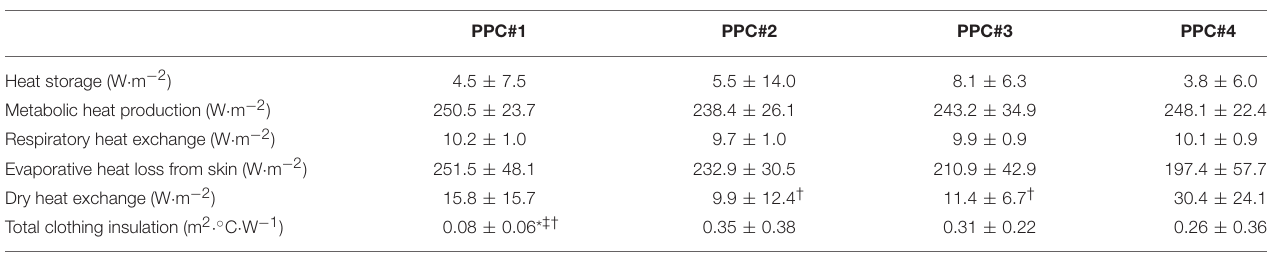
TABLE 3 | Estimated parameters of heat balance analysis (mean ± SD